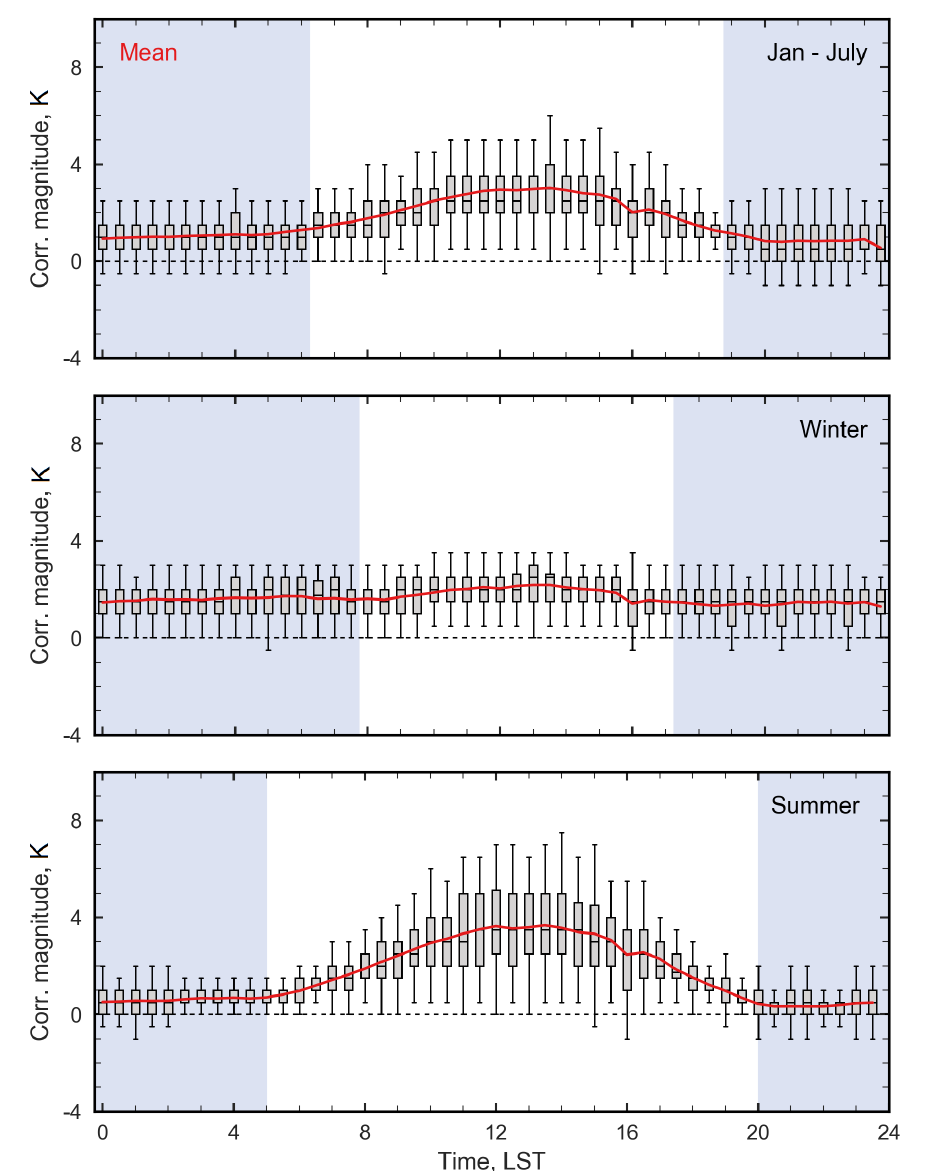
Figure 8. Atmospheric correction magnitudes calculated as the difference between T hem, r and T hem, b calculated from irradiances measured at 31.5 m for the duration of the study period at Sperrstrasse canyon. Grey shading indicates average nighttime for the interval. The red line indicates mean correction magnitude at each time step. Box edges represent the 25th and 75th percentiles with whiskers representing one standard deviation from the